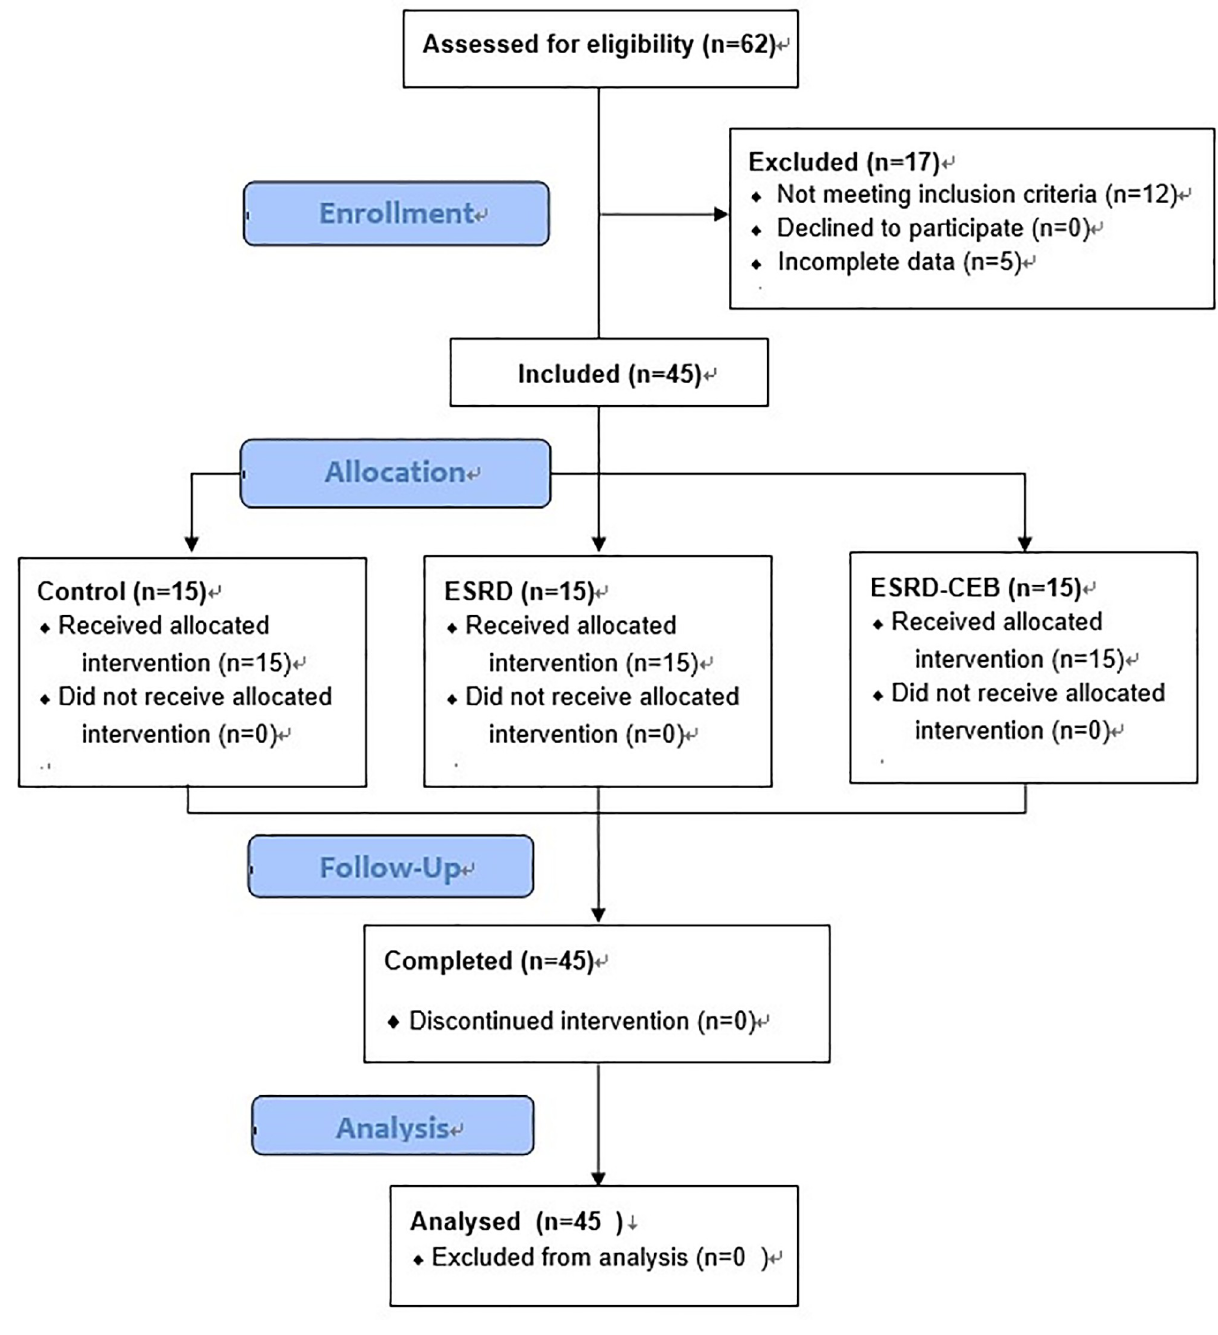
Fig 1. The flow diagram of the